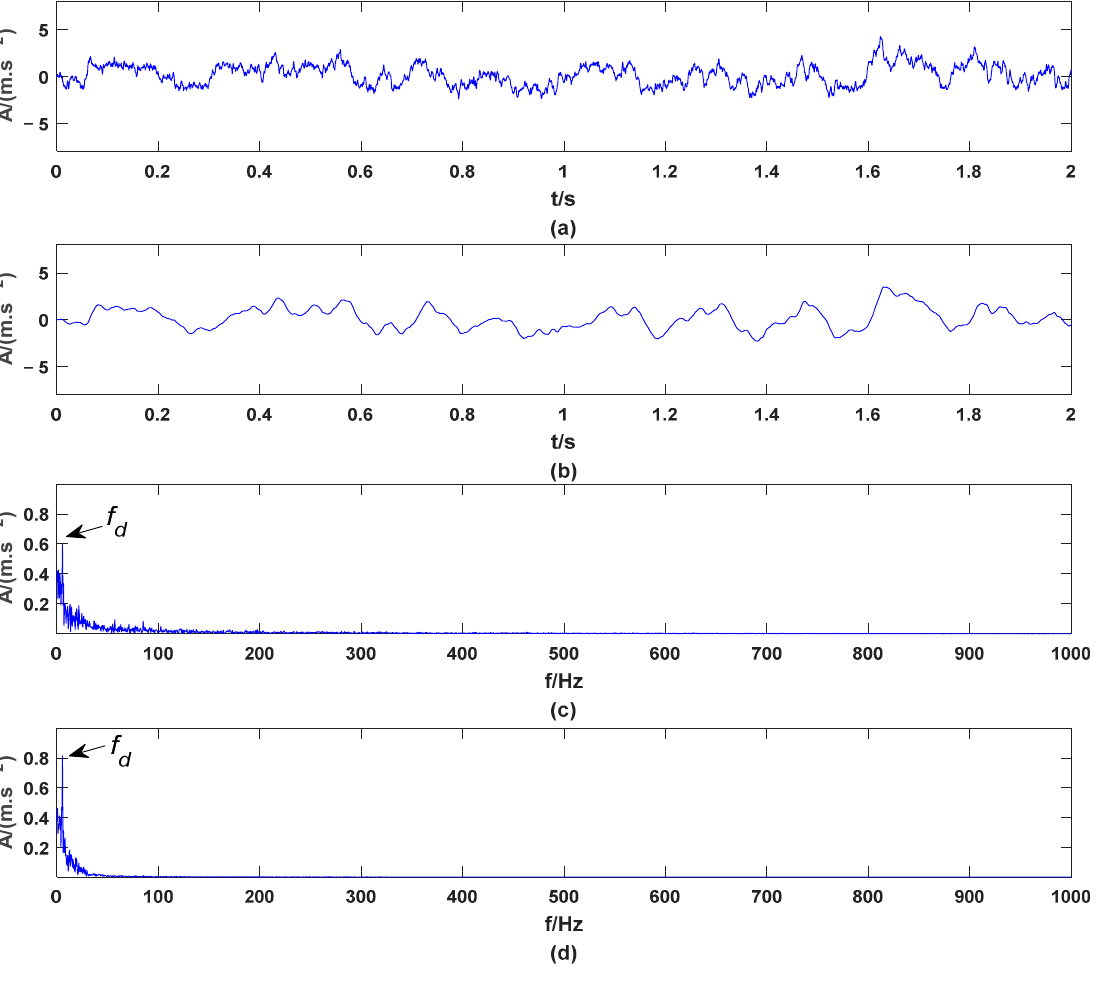
Figure 4. The output signal ( a ) time domain curve of the PTSR system ( b ) time domain curve of PTSR method in the underdamped state ( c ) frequency domain curve of PTSR method ( d ) frequency domain curve of PTSR method in the underdamped state ( 𝑚 = 3, 𝑝 = 0.5,𝑞 = 1.2 , 𝛾 = 1 ).